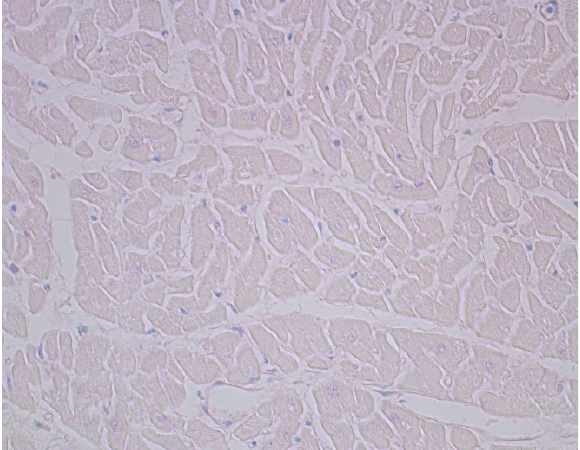
Fig. 8. Heart. Single lymphocytes and histiocytes between muscle fibers. Brache. EP 10, lens 40